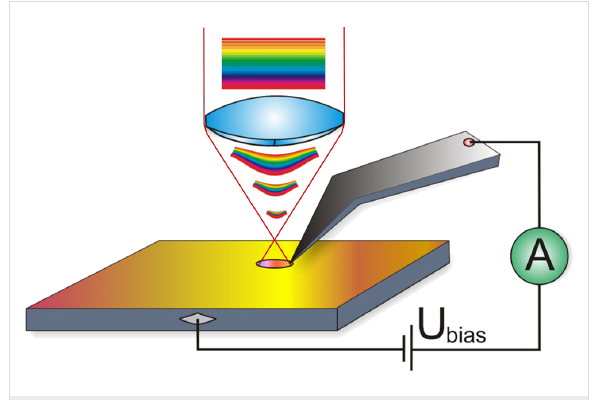
Figure 1: Schematic drawing of the PC-AFM setup. The sample in the present configuration was illuminated from the top side and biased. Use of ATEC-CONTPt™ probes helps to avoid shadowing by the